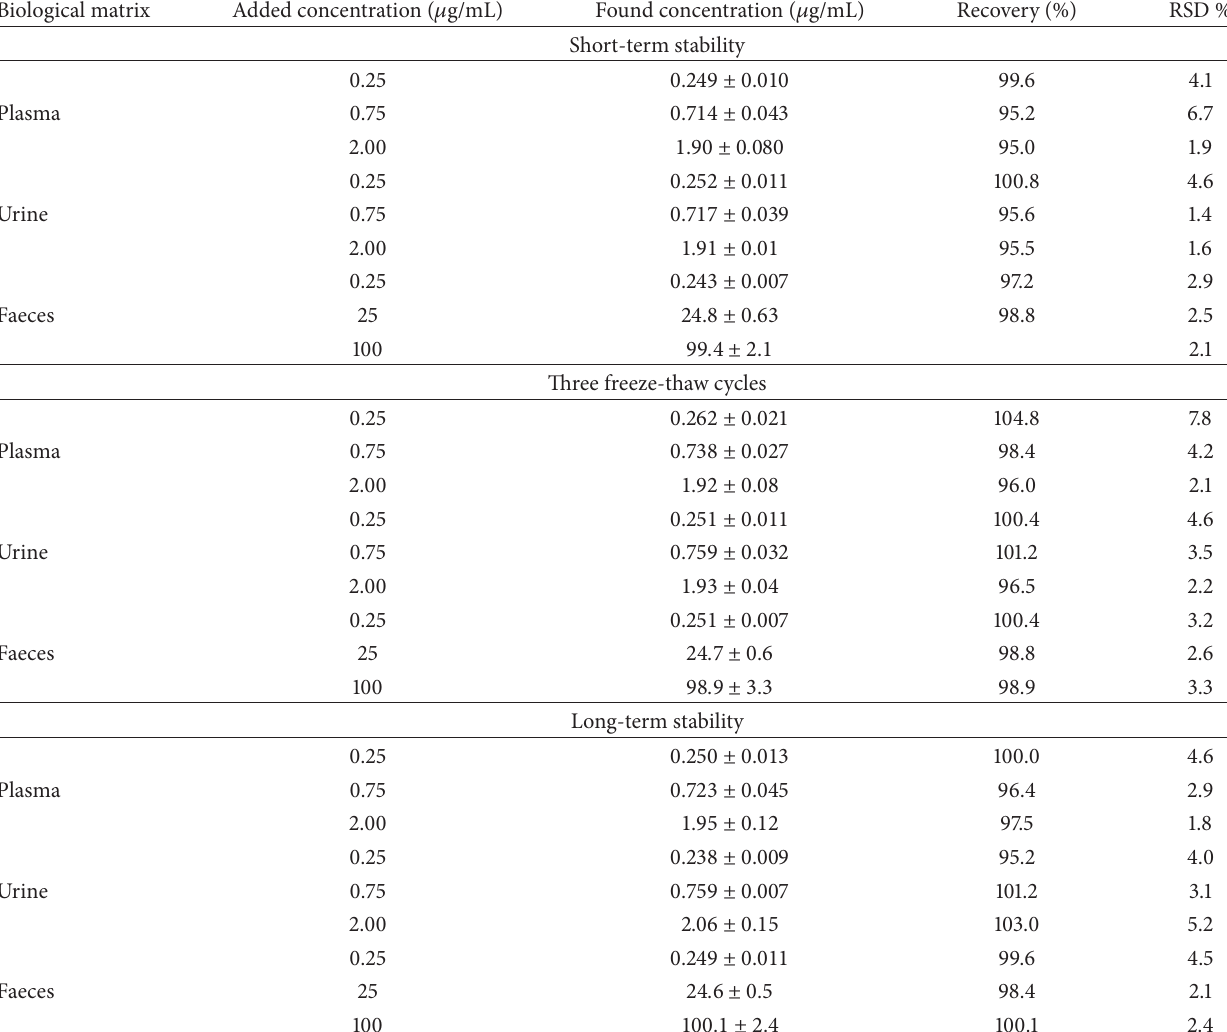
Table 3: Summary of stability studies of ergosterol in rat plasma, urine, and faeces under various storage conditions.